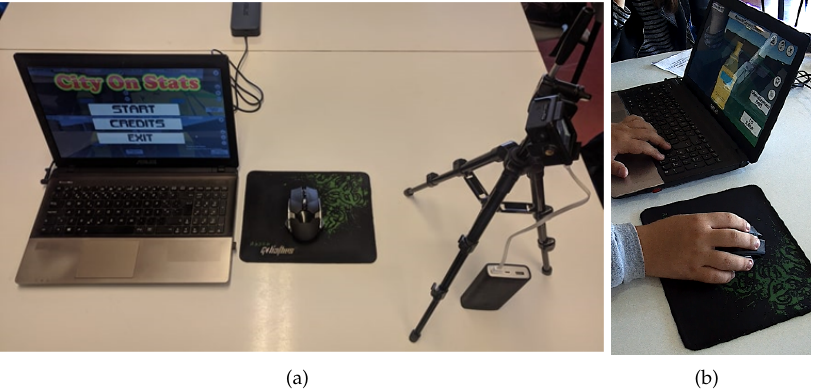
Figure 9. Test setup. ( a ) The setup consisted of a laptop running CityOnStats, a computer mouse, and a camera placed on a tripod to capture the participant’s interaction with the tool for later analysis. ( b ) A participant performing the